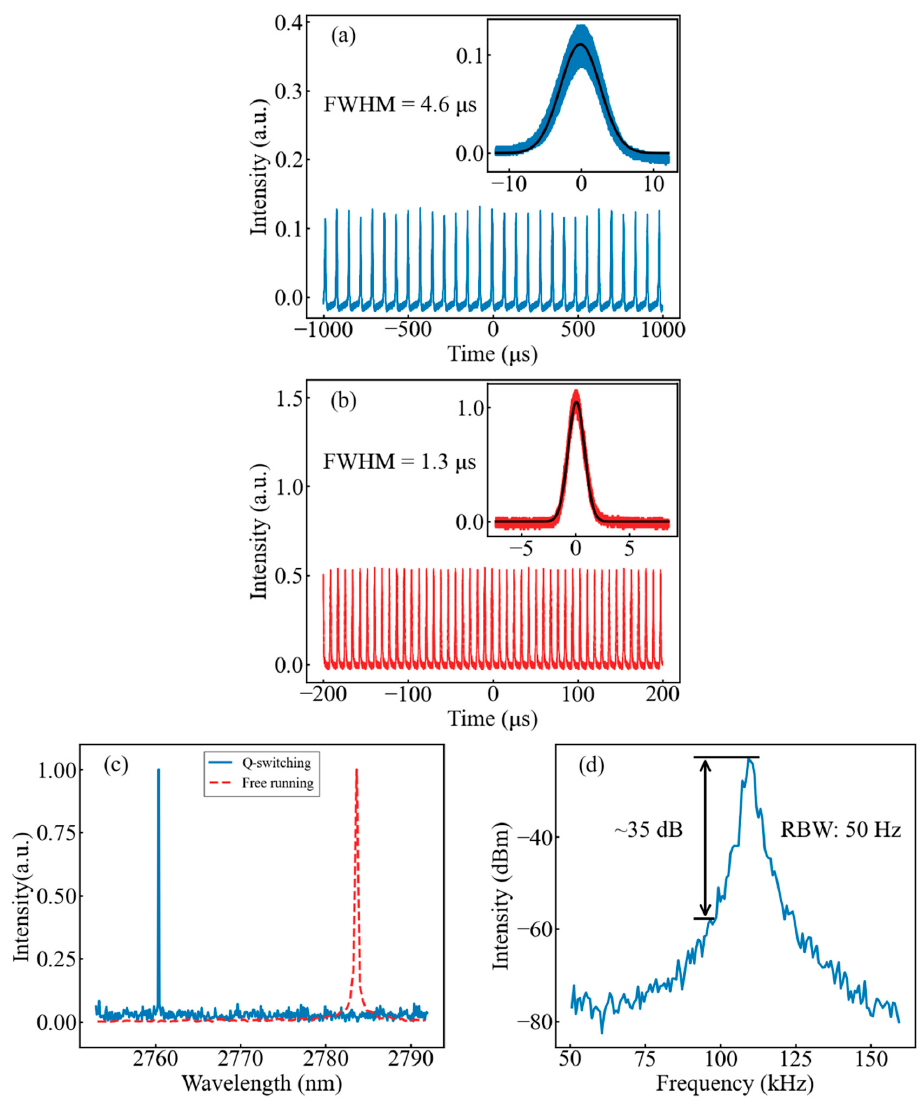
Figure 3. Q-switched laser pulse trains and single pulse envelope at a pump power of ( a ) 0.98 W and ( b ) 9.6 W. ( c ) Optical spectrum of Q-switched laser and free running laser in linear scale at a pump power of 9.6 W. ( d ) RF spectrum of Q-switched laser at a pump power of 9.6 W, measured with a resolution bandwidth (RBW) of 30